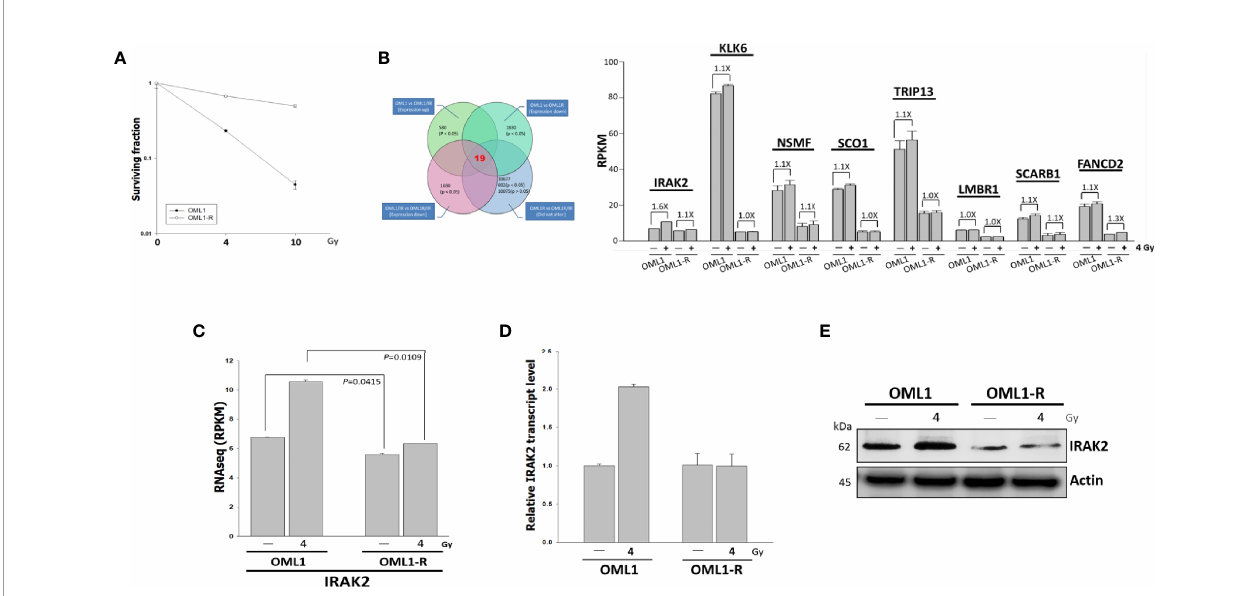
FIGURE 1 | Higher IRAK2 expression was associated with a higher radiosensitivity in the context of parental (i.e., OML1) and radioresistant (i.e., OML1-R) OSCC cells. (A) After exposure to 0, 4, and 10 Gy IR, colony-formation assay con fi rmed that OML1-R cells were relatively radioresistant when compared with parental OML1 cells. (B) Venn diagram showed the number of genes with apparent expression change before and after irradiation in OML1 and OML1-R cells (left). Bar graphs displayed 19 genes were up-regulated in OML1 cells, using a fi lter criterion at least 1.5-fold change with P < 0.05. By setting a threshold of RPKM>2, we identi fi ed eight reliable transcripts that were largely differentially expressed between the OML1 and OML1-R cells. The graph showed relative fold change in gene expression: control versus IR-treated cells (right). (C) The RPKM value of IRAK2 expression was plotted for OML1 and OML1-R cells treated with 4 Gy. (D) qPCR and (E) Western blotting revealed that IRAK2 expression, including mRNA and protein levels, were pronouncedly elevated in parental OML1, but not OML1-R cells. Densitometry-derived values (bottom) were normalized with the control set as 1. b -actin served as the loading control for